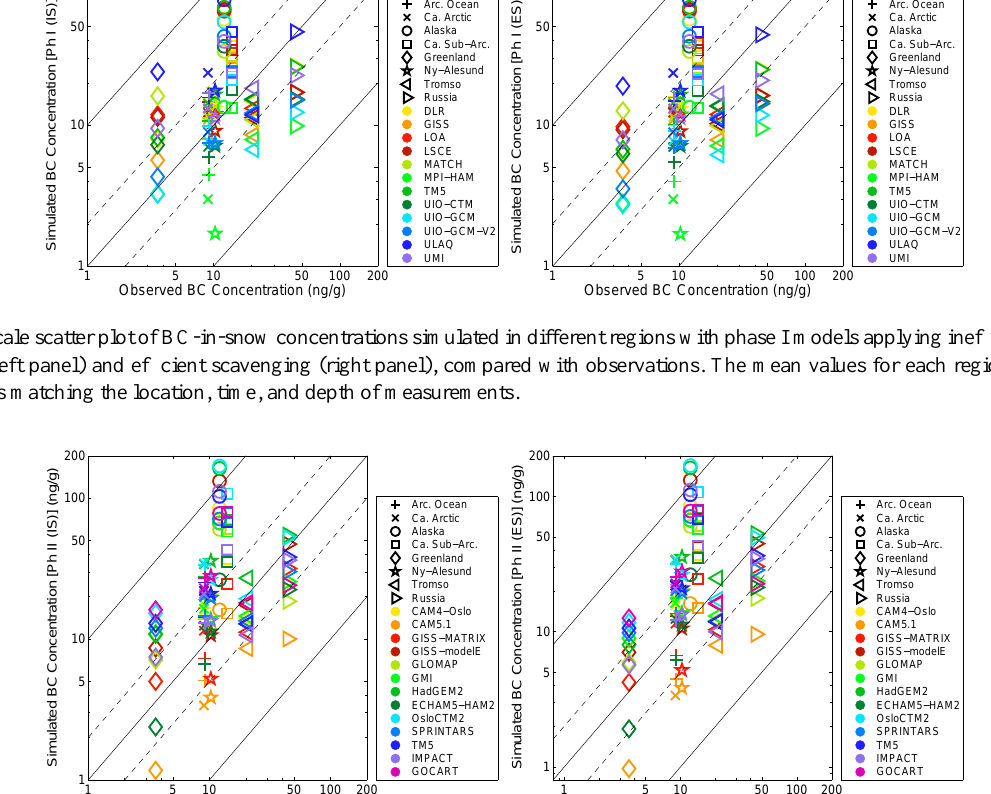
Fig. 3. Same as Fig. 2, but for phase II Fig. 3. Same as Figure 2, but for Phase II models.